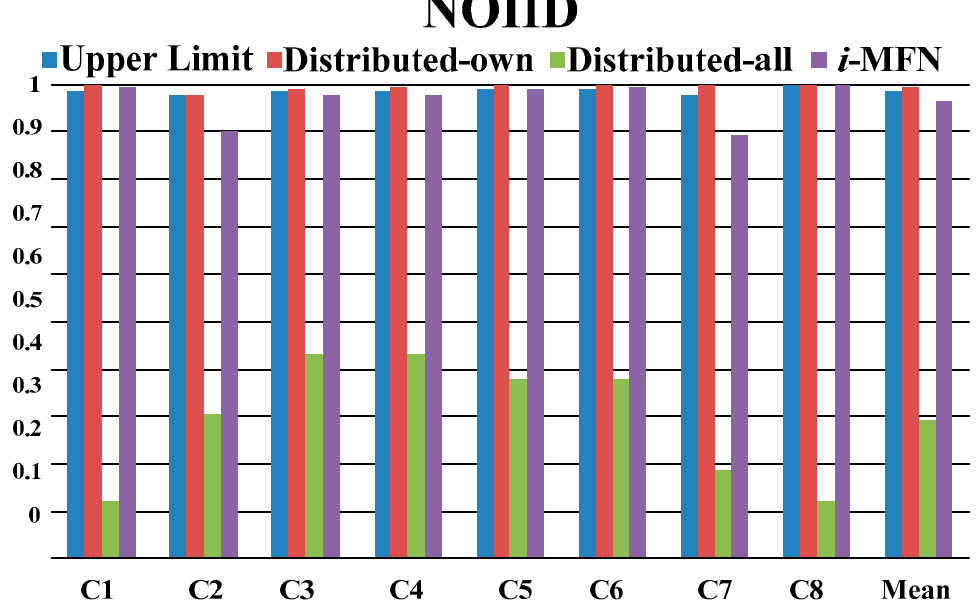
Figure 12. Accuracy rates trend of i-MFN under IID data distribution with network parameters federated.